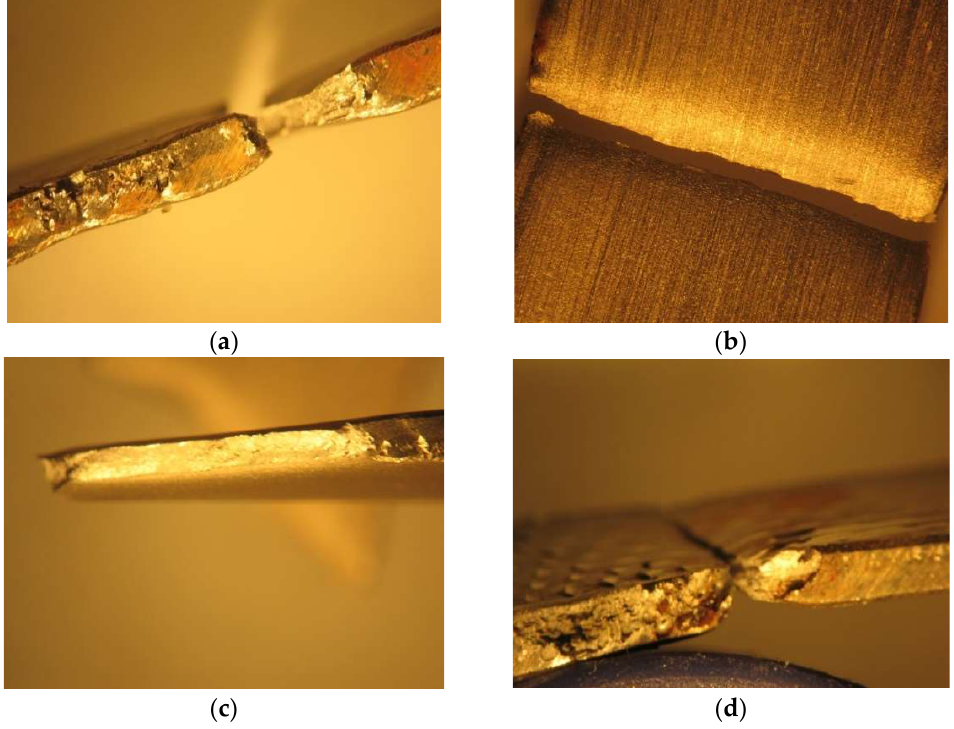
Figure 10. Fracture cross-section of the AISI 316L samples immersed in 5% NaClO and 100% NaClO for three weeks ( a , c ) and three months ( b , d ).